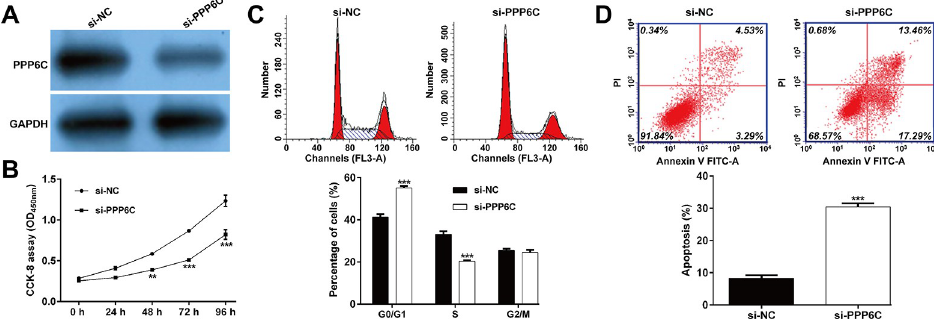
Fig 4. Effects of PPP6C knockdown on cell proliferation, cell cycle progression and apoptosis in AML cells. THP-1 cells were transfected with si-PPP6C or si-NC, respectively. (A) Western blot analysis was performed to measure the protein level of PPP6C in transfected THP-1 cells. (B) Cell proliferation was assessed by CCK-8 assay in transfected THP-1 cells. Flow cytometry assay was applied to determined cell cycle distribution (C) and apoptotic rate (D) in transfected THP-1 cells. Data are presented as mean ± SD of three independent experiments. �� p < 0.01, ��� p < 0.001, compared with si-NC.